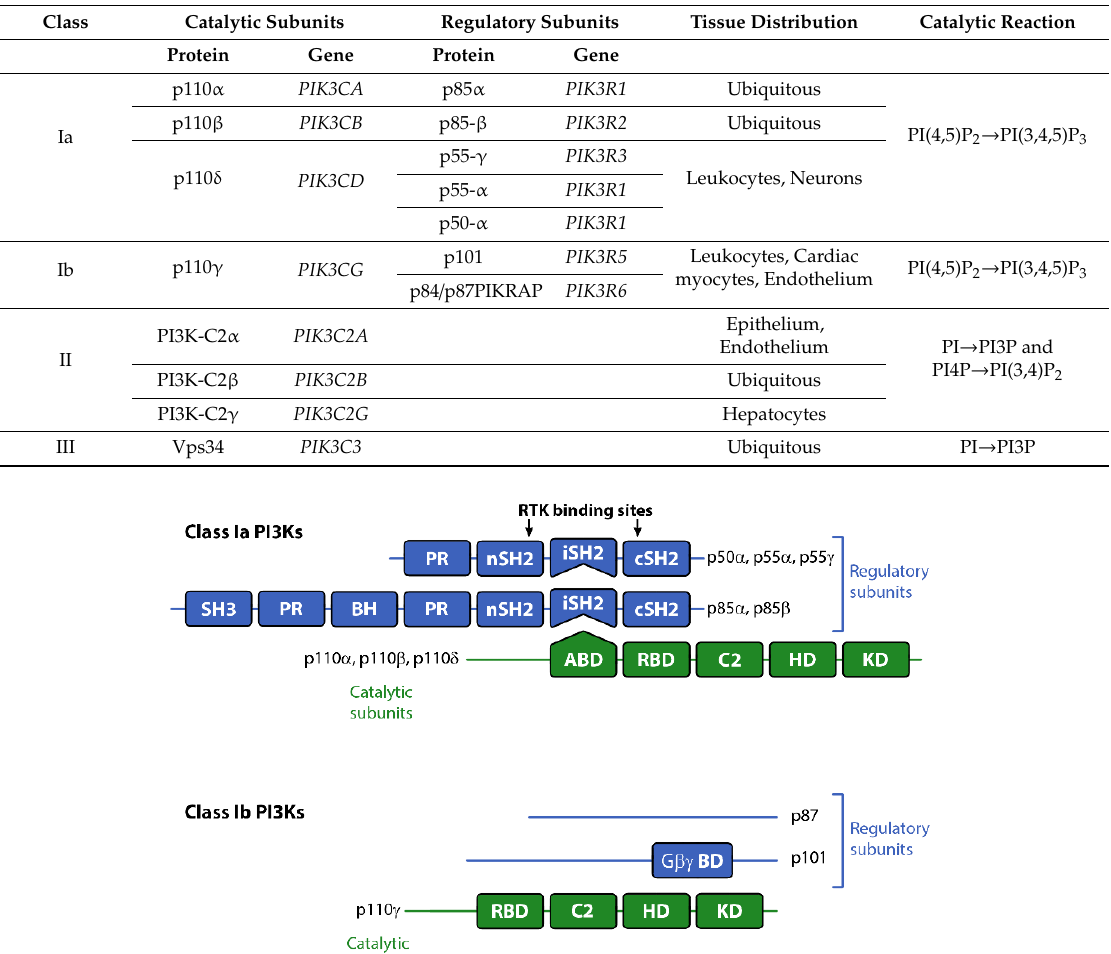
Table 1. Gene and protein names of catalytic and regulatory subunits that make up the Class Ia and Class Ib phosphoinositide 3-kinases (PI3K) heterodimers. Also shown are the Class II and III phosphoinositide 3-kinases (PI3Ks) members, tissue distribution and the reaction catalyzed by the different classes of PI3K.